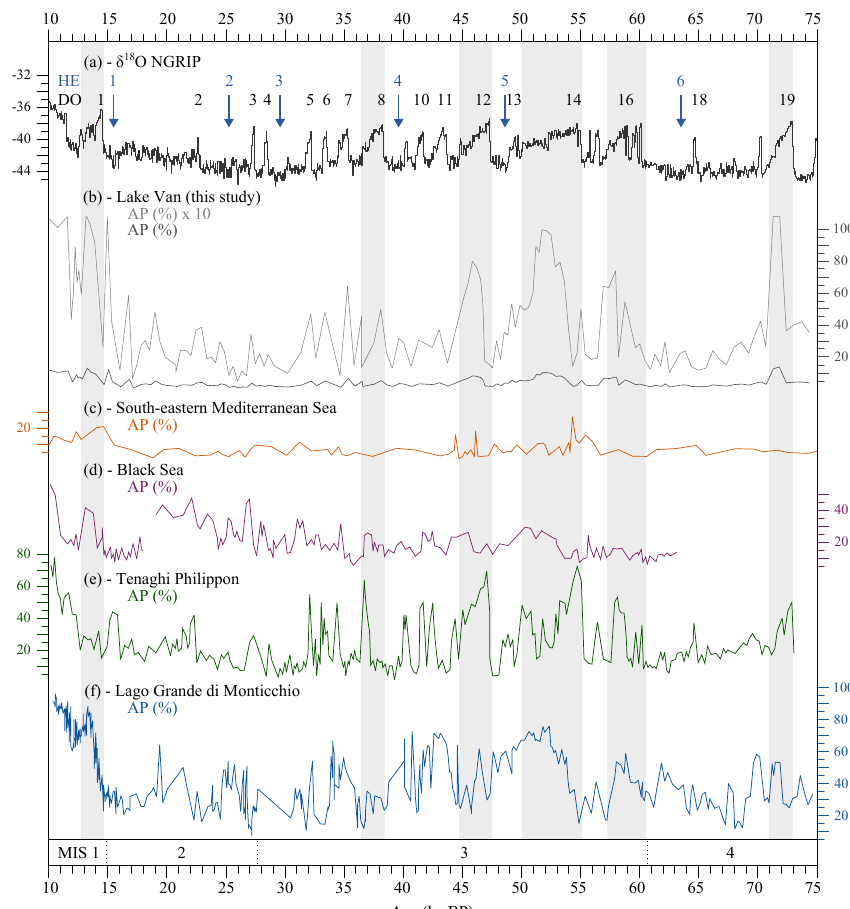
Figure 4. Regional comparison of vegetation dynamics and climate variability in the central and eastern Mediterranean area and Black Sea region concerning Dansgaard–Oeschger cycles (DO) and Heinrich events (HE). The gray bars represent the most pronounced DO interstadials DO 19, 17–16, 14, 12, 8, and DO 1, which are discussed in Sect. 5.2. (a) δ 18 O-profile from NGRIP ice core, Greenland (NGRIP members, 2004), labeled with DO 1 to 19 and HE 1 to HE 6 (Bond et al., 1993); (b) Lake Van arboreal pollen record (AP in %, black line) with 10- fold exaggeration (gray line); (c) marine arboreal pollen record (Core 9509) obtained from the south-eastern Levantine Basin (south-eastern Mediterranean Sea; Langgut et al., 2011); (d) AP record from the SE Black Sea (core 22-GC3 for the period from 10 to 18kaBP after Shumilovskikh et al. (2012) and core 25-GC1 for the sequence between 19 and 63kaBP (Shumilovskikh et al., 2014); (e) arboreal pollen record from Tenaghi Philippon, Greece (Müller et al., 2011); (f) AP record from Lago Grande di Monticchio, southern Italy (Allen et al., 1999). MIS – Marine Isotope